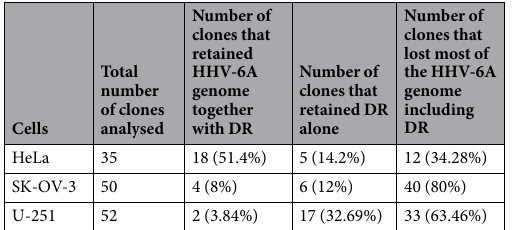
Table 1. Differences in loss of viral genome in different cell lines as studied by qPCR analysis of HHV-6A genome equivalents and DR equivalents in different clonal population of